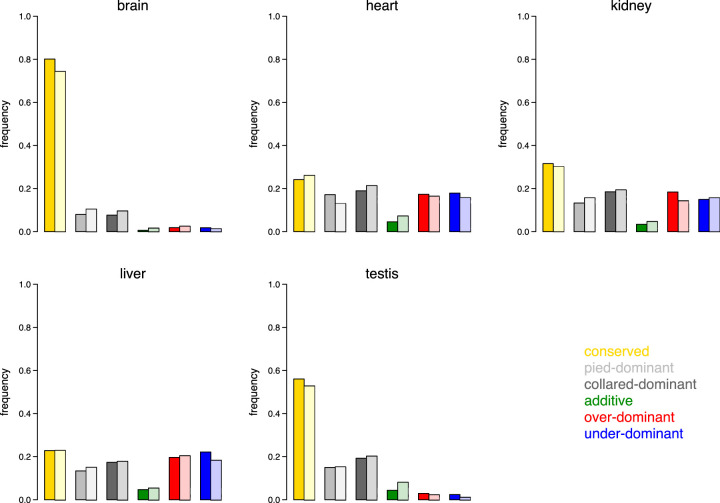
Inheritance mode of gene expression patterns across the five tissues, separately for genes located on autosomes (opaque colors) and the Z Chromosome (transparent colors). The height of the bars shows the frequency of genes in each of the categories.